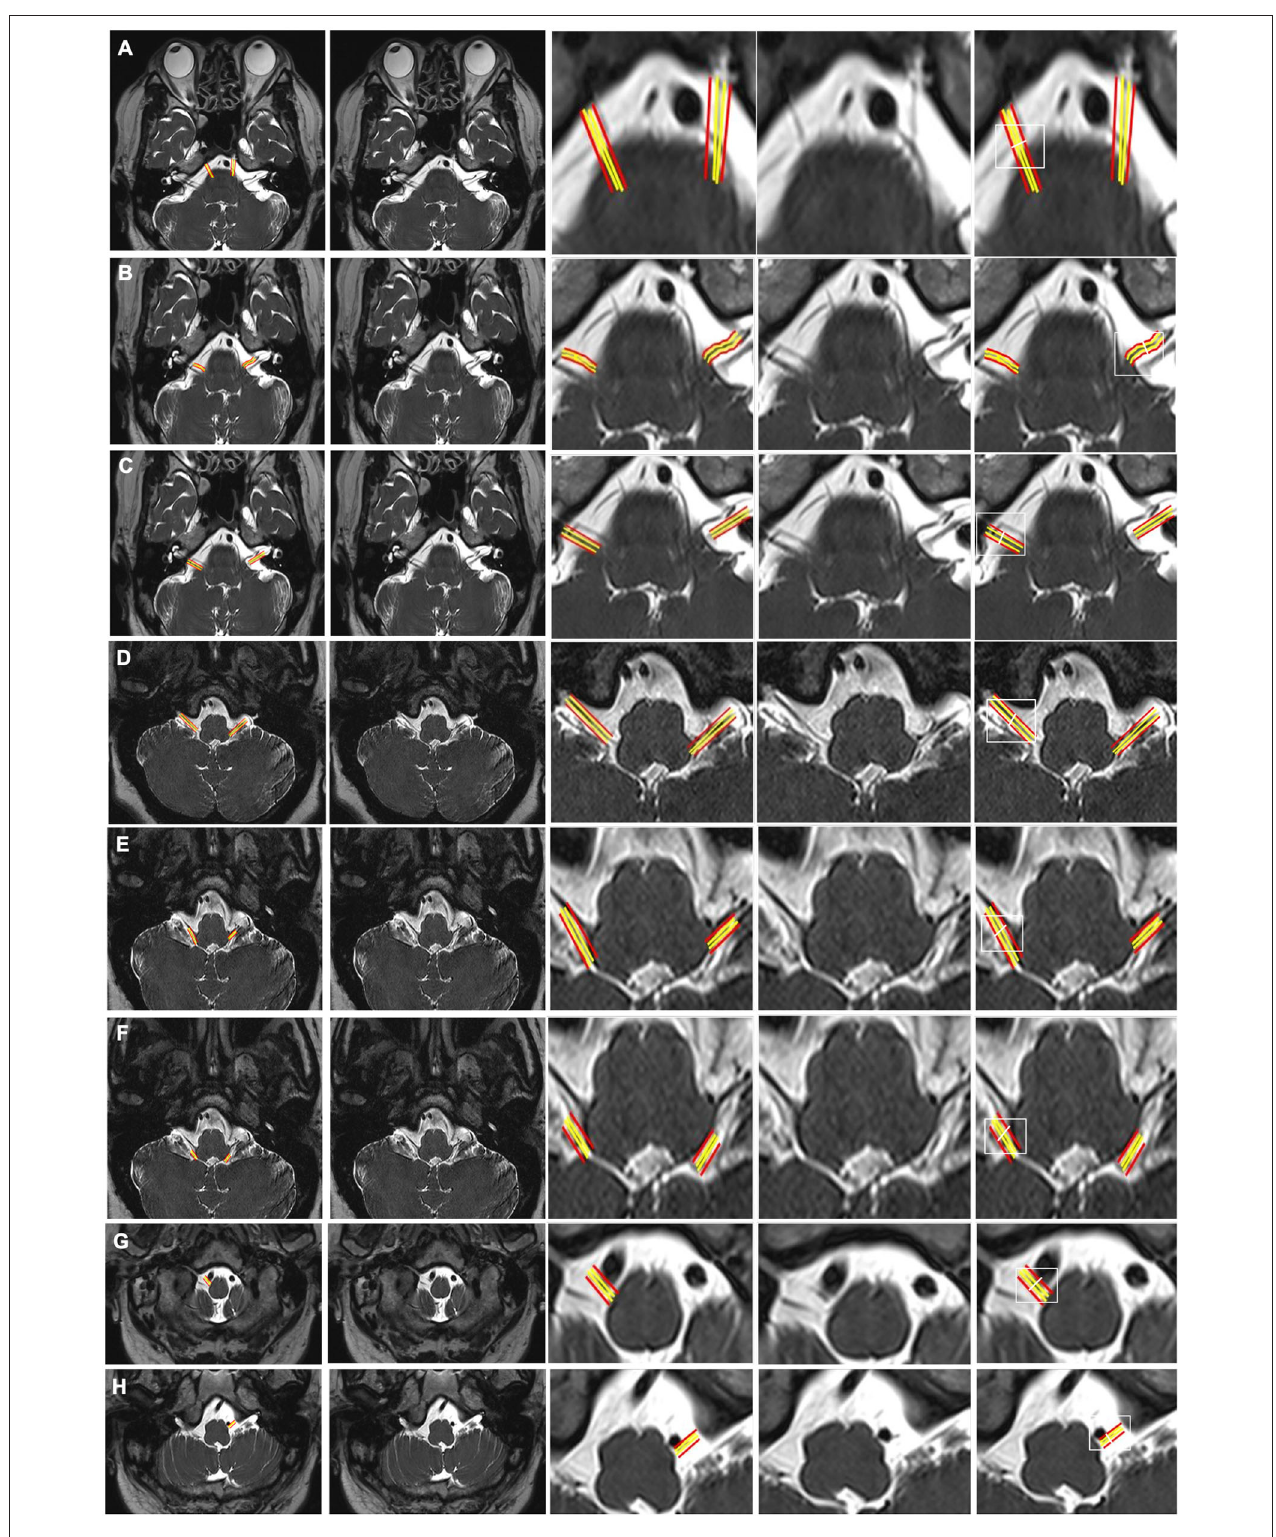
FIGURE 2 | CSF-filled peri-neural spaces surrounding the cranial nerves 6–12 (CN VI-CN XII). (A) Abducens nerves (CN VI) (two original images, two corresponding magnified images and measurement location); (B) Facial nerves (CN VII) (two original images, two corresponding magnified images and measurement location); (C) Vestibulocochlear nerves (CN VIII) (two original images, two corresponding magnified images and measurement location); (D) Glossopharyngeal nerves (CN IX) (two